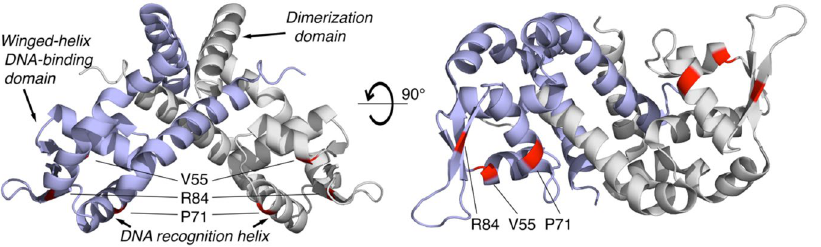
Figure 4. HMPC resistance-associated mutations in MgrA map to the DNA-binding domain. The MgrA dimer (PDB: 2BV6) is shown with the two equivalent subunits colored light blue and white/grey. Missense variants at Val55, Pro71, and Arg84 (shown in red) are all found in the winged-helix DNA-binding domain (left, bottom half), including in the DNA recognition helix. Image created in PyMOL with Flaticon.